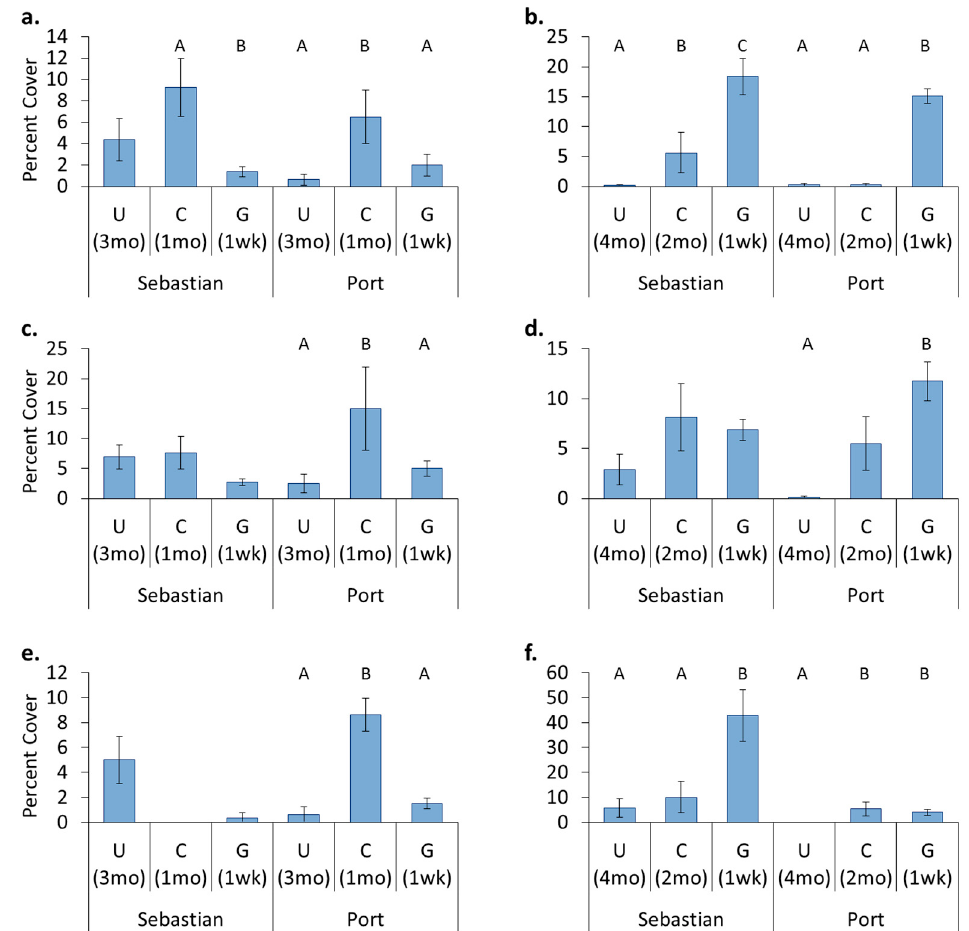
Figure 9. Differences in average cover of hydroids on IS700 ( a , b ), IS900 ( c , d ), and DC3140 ( e , f ). ( a ) In June on IS700 in Sebastian, cover of hydroids was significantly higher on cleaned than on groomed panels ( p = 0.004). In Port Canaveral, cover of hydroids was significantly higher on cleaned than on uncleaned ( p < 0.001) and groomed panels ( p = 0.003). ( b ) In July on IS700 in Sebastian, cover of hydroids was significantly higher on groomed than on uncleaned or cleaned panels ( p < 0.001); cover was higher on cleaned than on uncleaned panels ( p = 0.04). In Port Canaveral, cover